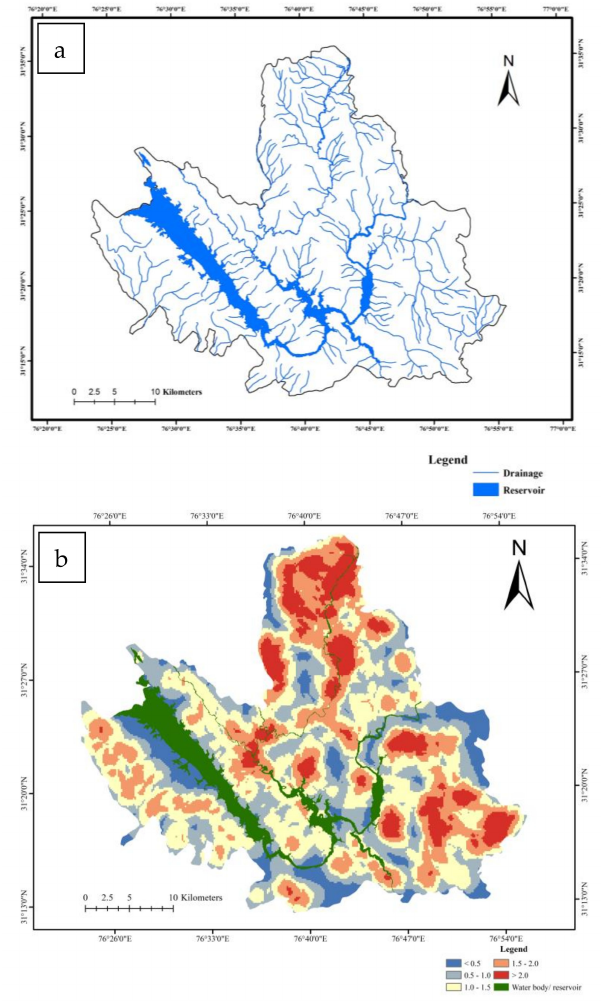
Figure 4. ( a ) Drainage map of Bilaspur district; ( b ) Drainage density map of Bilaspur